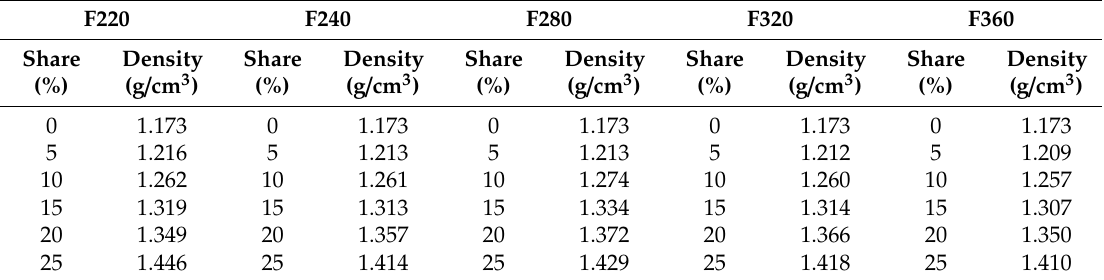
Table 3. Density of samples made of L285 resin and H285 hardener with an addition of alundum with the following grains: F220, F240, F280, F320, and F360, with various percentage mass shares.